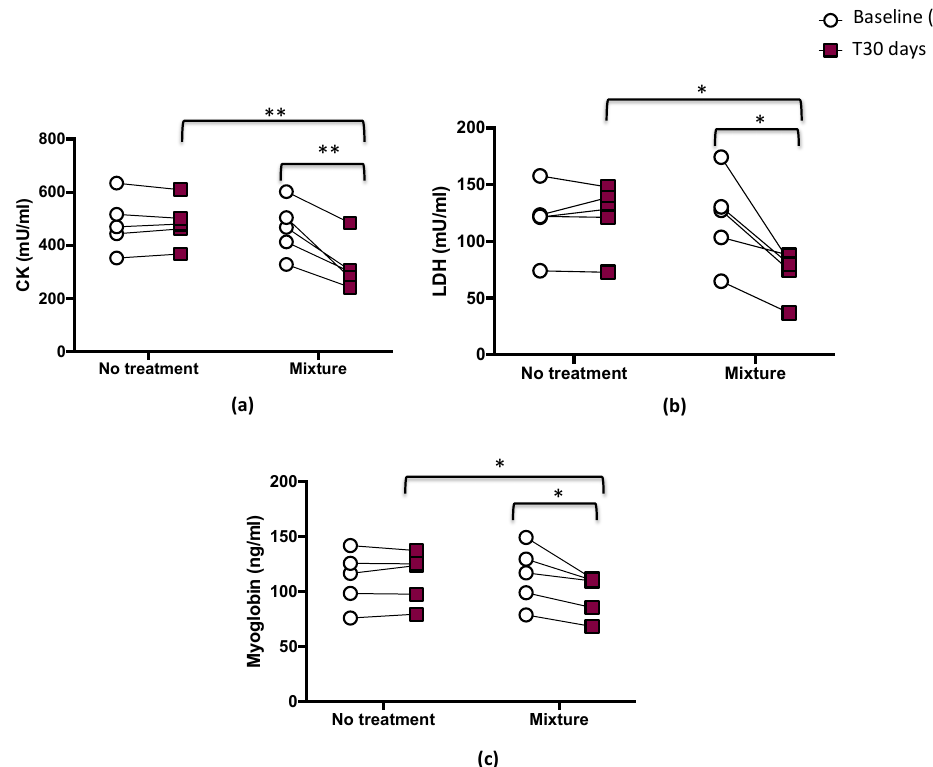
Figure 2. Serum levels of CK ( a ), LDH ( b ), and myoglobin ( c ) before (T0) and 1 month (T30 days) after mixture intake ( n = 5) or no-treatment period ( n = 5) in athletes. Data are expressed as mean ± SD. * p < 0.05, ** p < 0.01. Table 3. Biomarker levels before and after treatment and no-treatment